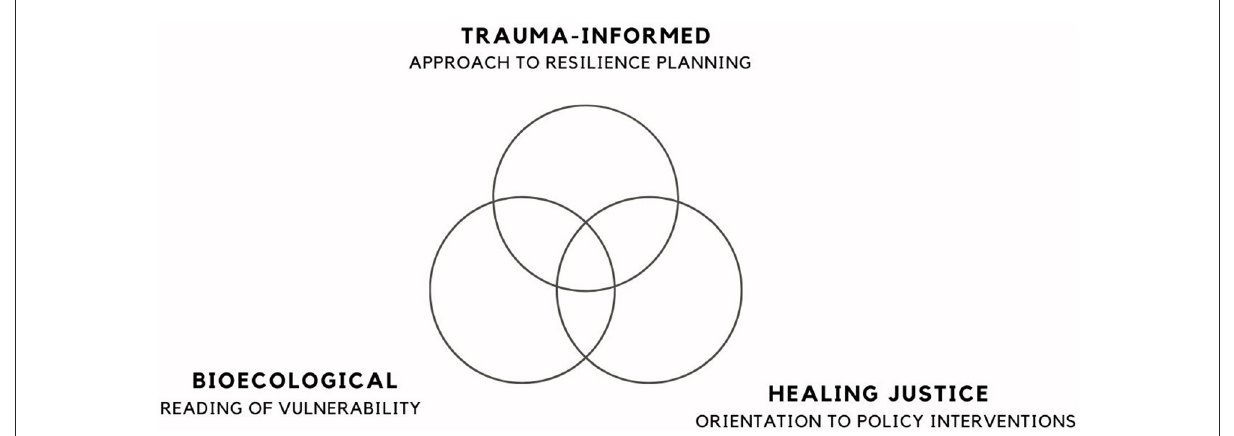
FIGURE1 The integrative resilience model (Camponeschi,